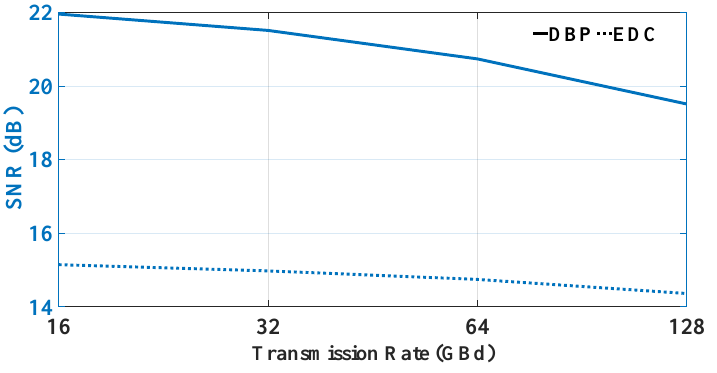
Figure 4. The central-channel SNR values in Nyquist-spaced WDM DP-16QAM nonlinear coherent fiber systems with transmission rates of 16, 32, 64 and 128 GBd, with transmission bandwidth fixed at 4.5